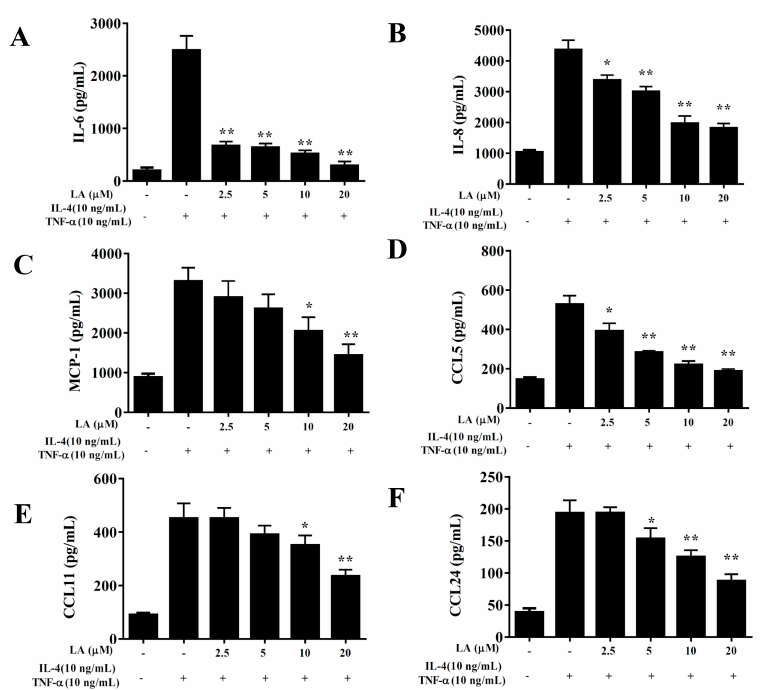
Figure 9. Effects of licochalcone A (LA) on cytokine and chemokine production in BEAS ‐ 2B cells. Figure 9. E ff ects of licochalcone A (LA) on cytokine and chemokine production in BEAS-2B cells. ELISA shows ( A ) IL ‐ 6, ( B ) IL ‐ 8, ( C ) MCP ‐ 1, ( D ) CCL5, ( E ) CCL11, and ( F ) CCL24 levels in BEAS ‐ 2B ELISA shows ( A ) IL-6, ( B ) IL-8, ( C ) MCP-1, ( D ) CCL5, ( E ) CCL11, and ( F ) CCL24 levels in BEAS-2B cells treated with TNF ‐α , IL ‐ 4, and/or LA. Data are presented as mean ± SEM. * P < 0.05, ** P < 0.01 cells treated with TNF- α , IL-4, and / or LA. Data are presented as mean ± SEM. * P < 0.05, ** P < 0.01 compared to BEAS ‐ 2B cells stimulated with TNF ‐α and IL ‐ 4. Three independent experiments were analyzed and compared to TNF ‐α and IL ‐ 4. compared to BEAS-2B cells stimulated with TNF- α and IL-4. Three independent experiments were